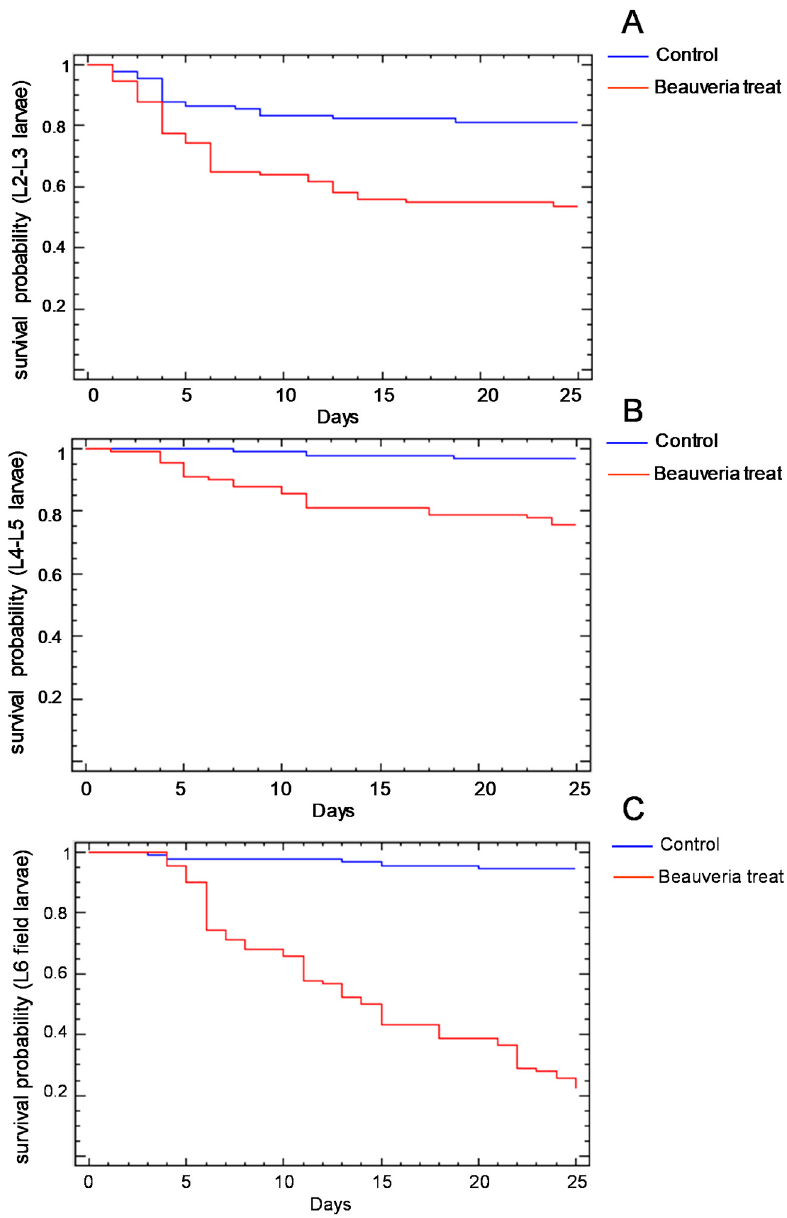
Figure 2. Survival probability of the L2–L3 ( A ), L4–L5 ( B ) and field-collected L6 ( C ) Cydalima perspectalis larvae treated with the identified strain of Baeuveria bassiana or with the control sterile aqueous solution. Table 4. Statistics of the analysis comparing the survival probability of the larvae of different ages treated with the control solution with the survival probability of the larvae treated with the Beauveria bassiana solution.